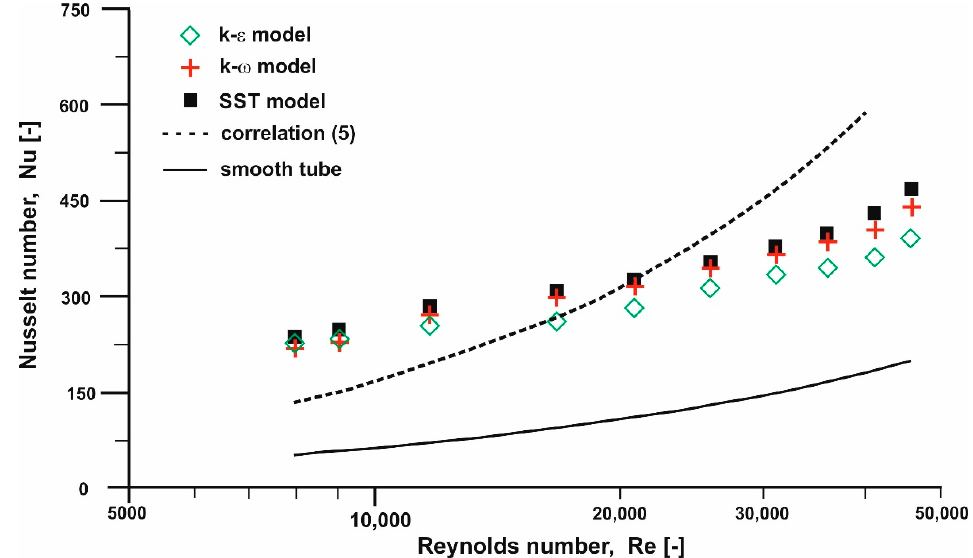
Figure 8. Comparison between Nusselt number values obtained from CFD modelling and correlation (5) for a tube with internal spiral ribs and for a smooth tube (heater power—7 kW).